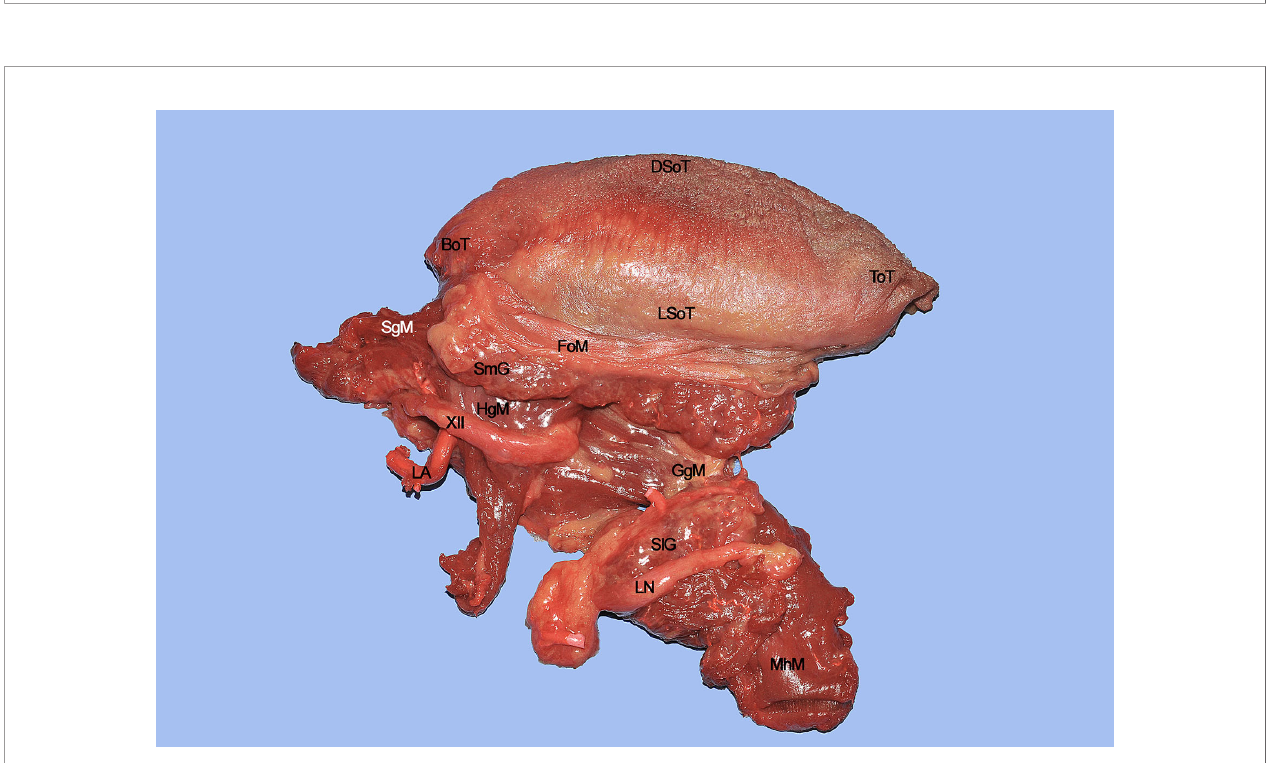
FIGURE 14 | BoT, base of tongue; DSoT, dorsal surface of tongue; FoM, fl oor of mouth; GgM, genioglossus muscle; HgM, hyoglossus muscle; LA, lingual artery; LN, lingual nerve; LSoT, lateral surface of tongue; MhM, mylohyoid muscle; SgM, styloglossus muscle; SlG, sublingual gland; ToT, tip of tongue; XII, hypoglossal nerve.